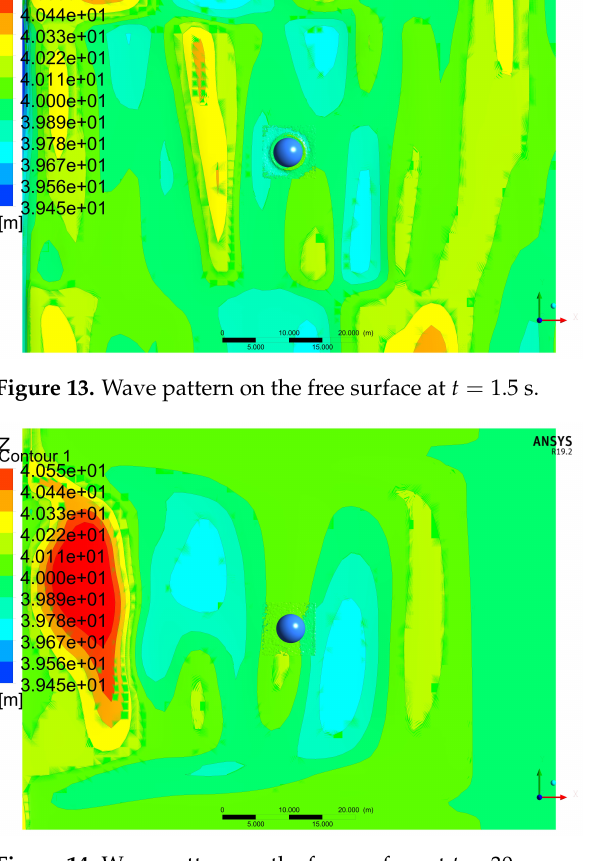
Figure 14. Wave pattern on the free surface at t = 30 s.